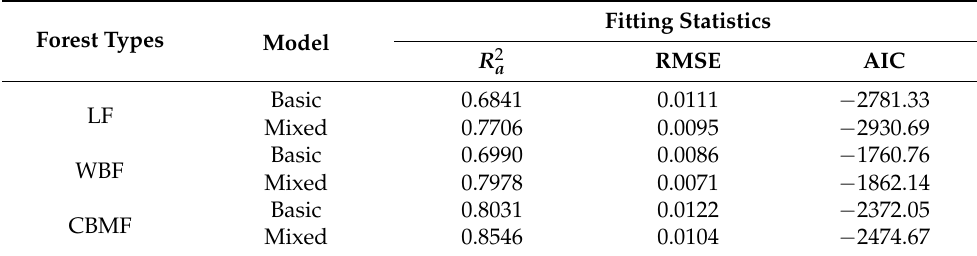
Table 3. Model fitting of the best basic and mixed-effects model for the three forest types. Forest